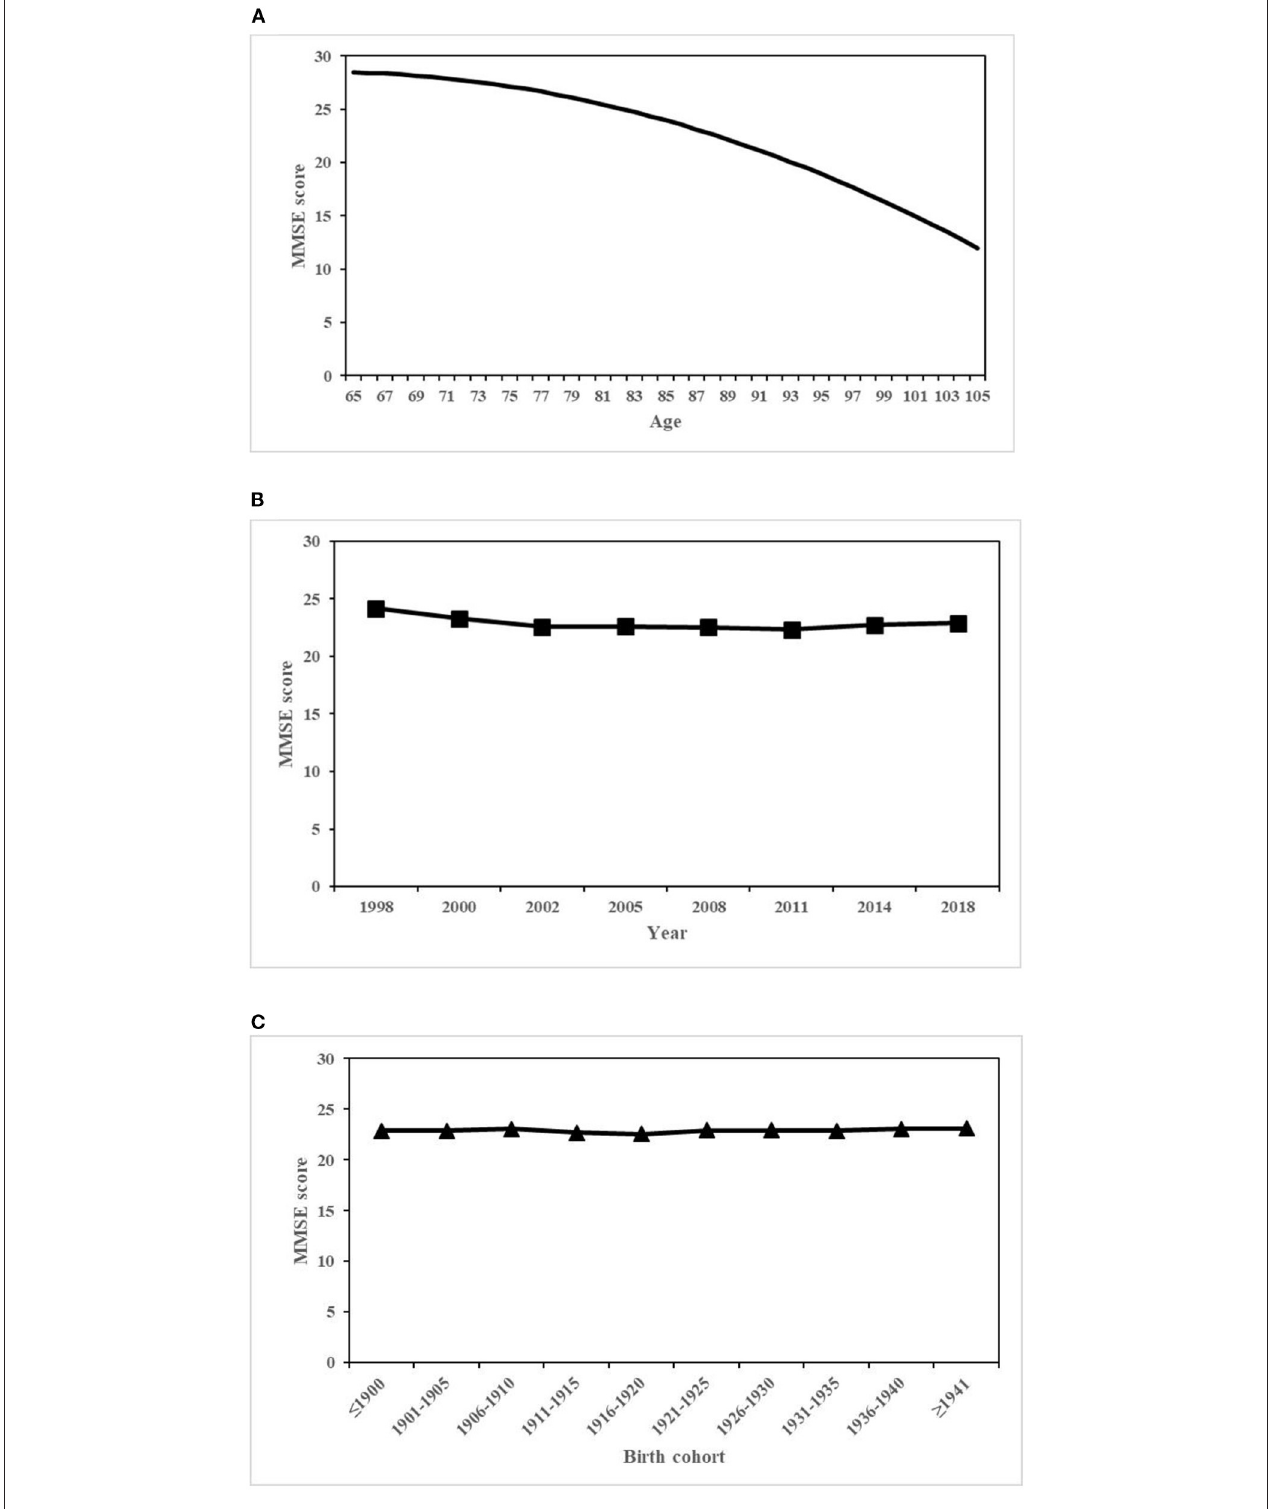
FIGURE 1 | Overall age, period, and cohort effects on MMSE scores. (A) Age. (B) Period. (C) Cohort.